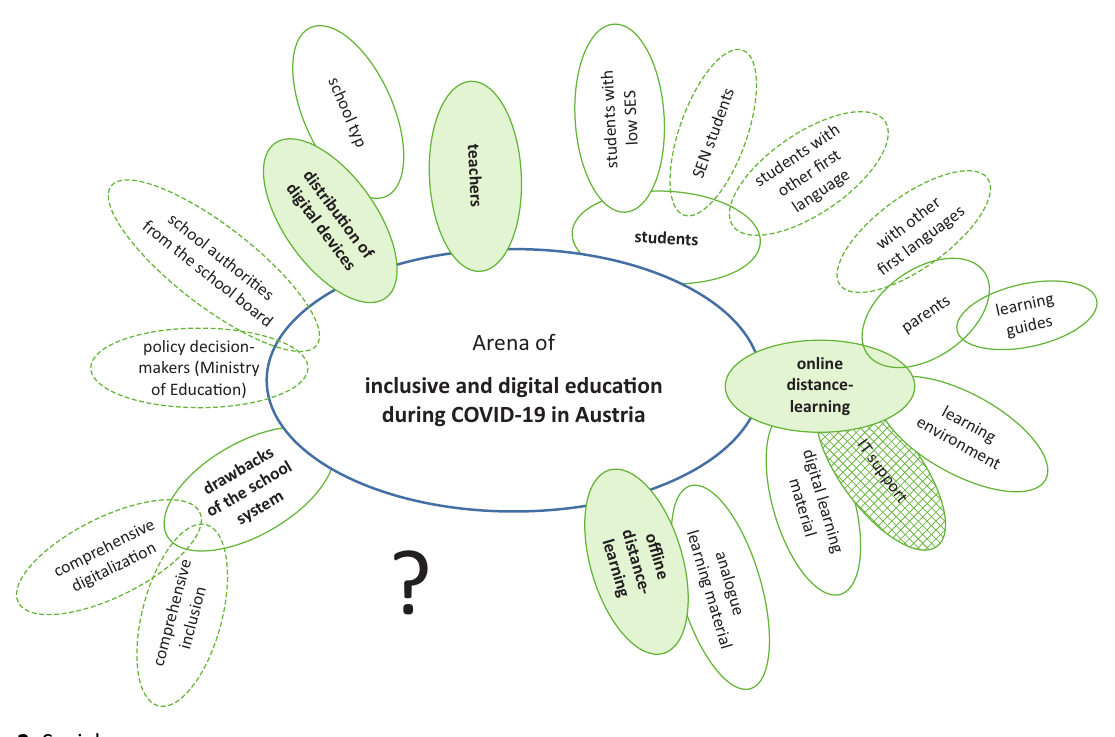
Figure 2. Social arena